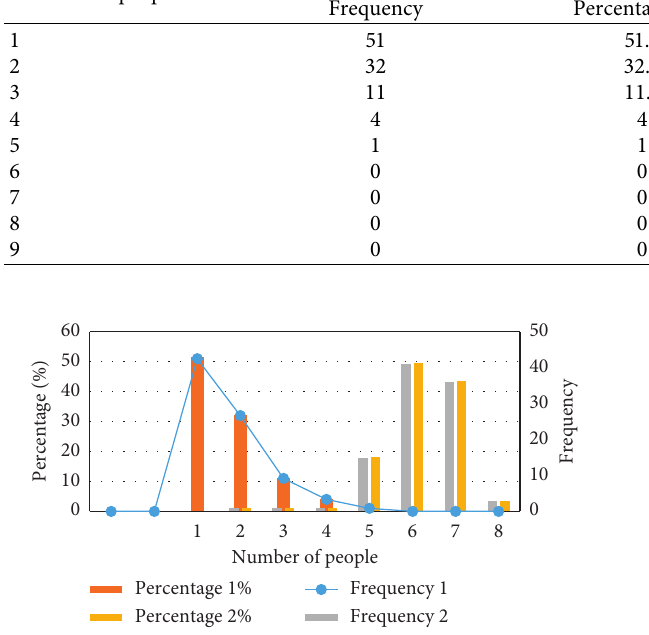
Figure 4: Analysis of the passing factors and their observed variables.